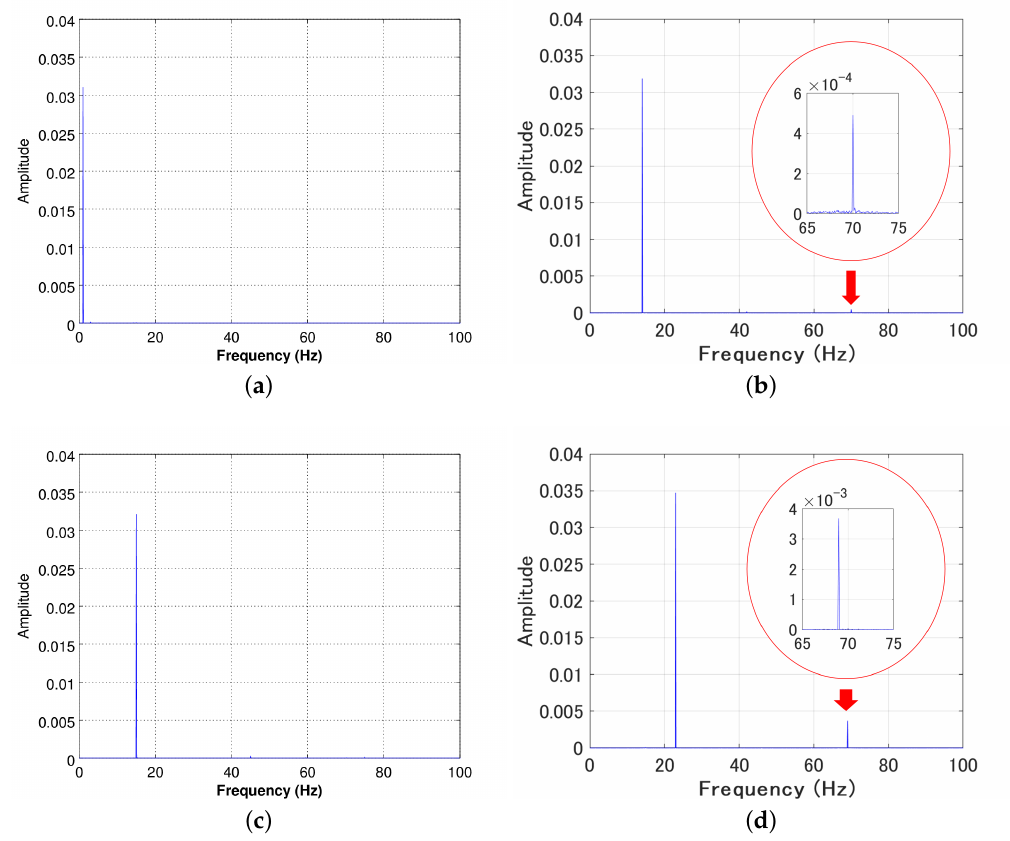
Figure 6. The results of the fast Fourier transform (FFT) analysis of the responses of our piezoelectric actuator to ( a ) 1, ( b ) 14, ( c ) 15, and ( d ) 23 Hz sinusoidal